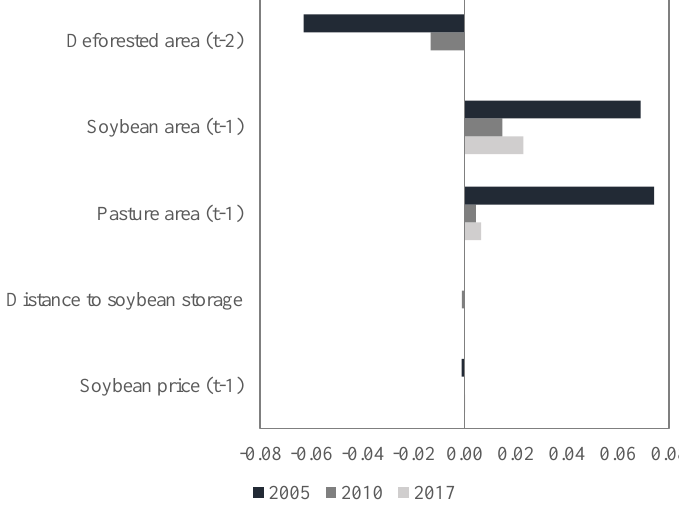
Figure 3. Standardized regression coefficients for soybean expansion models of 2005, 2010, and 2017, significant at p ≤